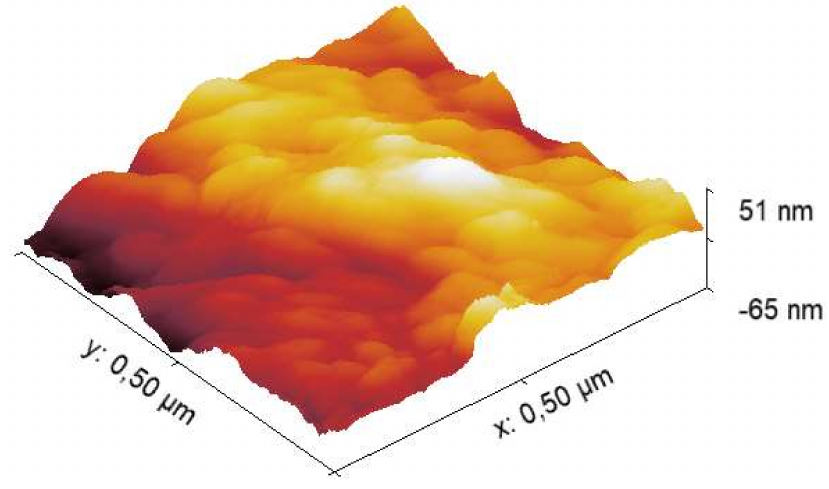
Figure 8. Topography of the Hydroxyapatite obtained by Pinpoint method.Due to the soft sample, a setpoint of 30 nN–40 nN was used in order to appreciate the shape of the grains on the